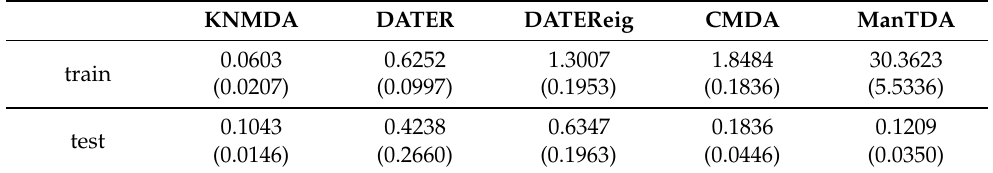
Table 12. Average execution times in seconds (and standard deviations) for HOSVD tensors, on a training set of 40 tensors and a test set of 100